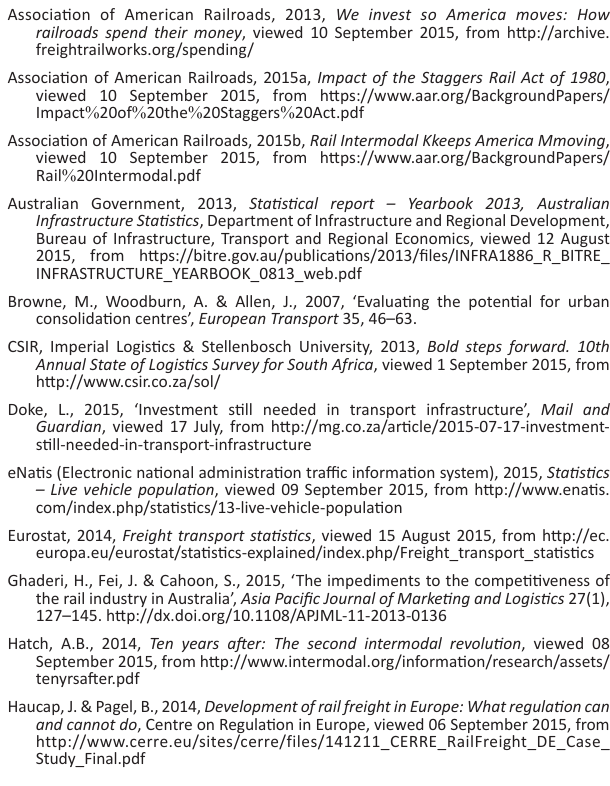
FIGURE 10: South African gross domestic product – primary and secondary sectors (constant 2010